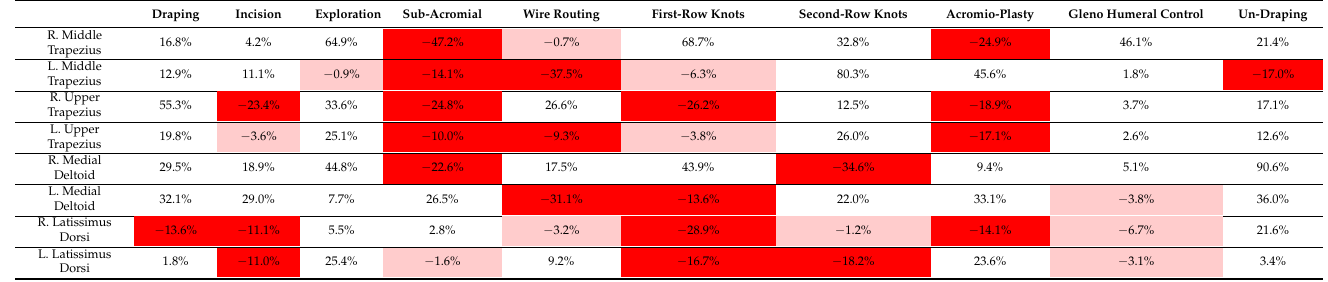
Table 4. Relative difference in MPF between the beginning and the end of each stage for all muscles expressed in %. The MPF evolutions between the first 3 seconds and the last 3 s of each stage with respect to MPF from the 3 first seconds of each stage are shown. All negative values are highlighted. The values between 0 and − 8% are in pink. The values < − 8% are in red. A drop of 8% or greater in MPF after a task is considered a robust marker of fatigue in the literature [31].